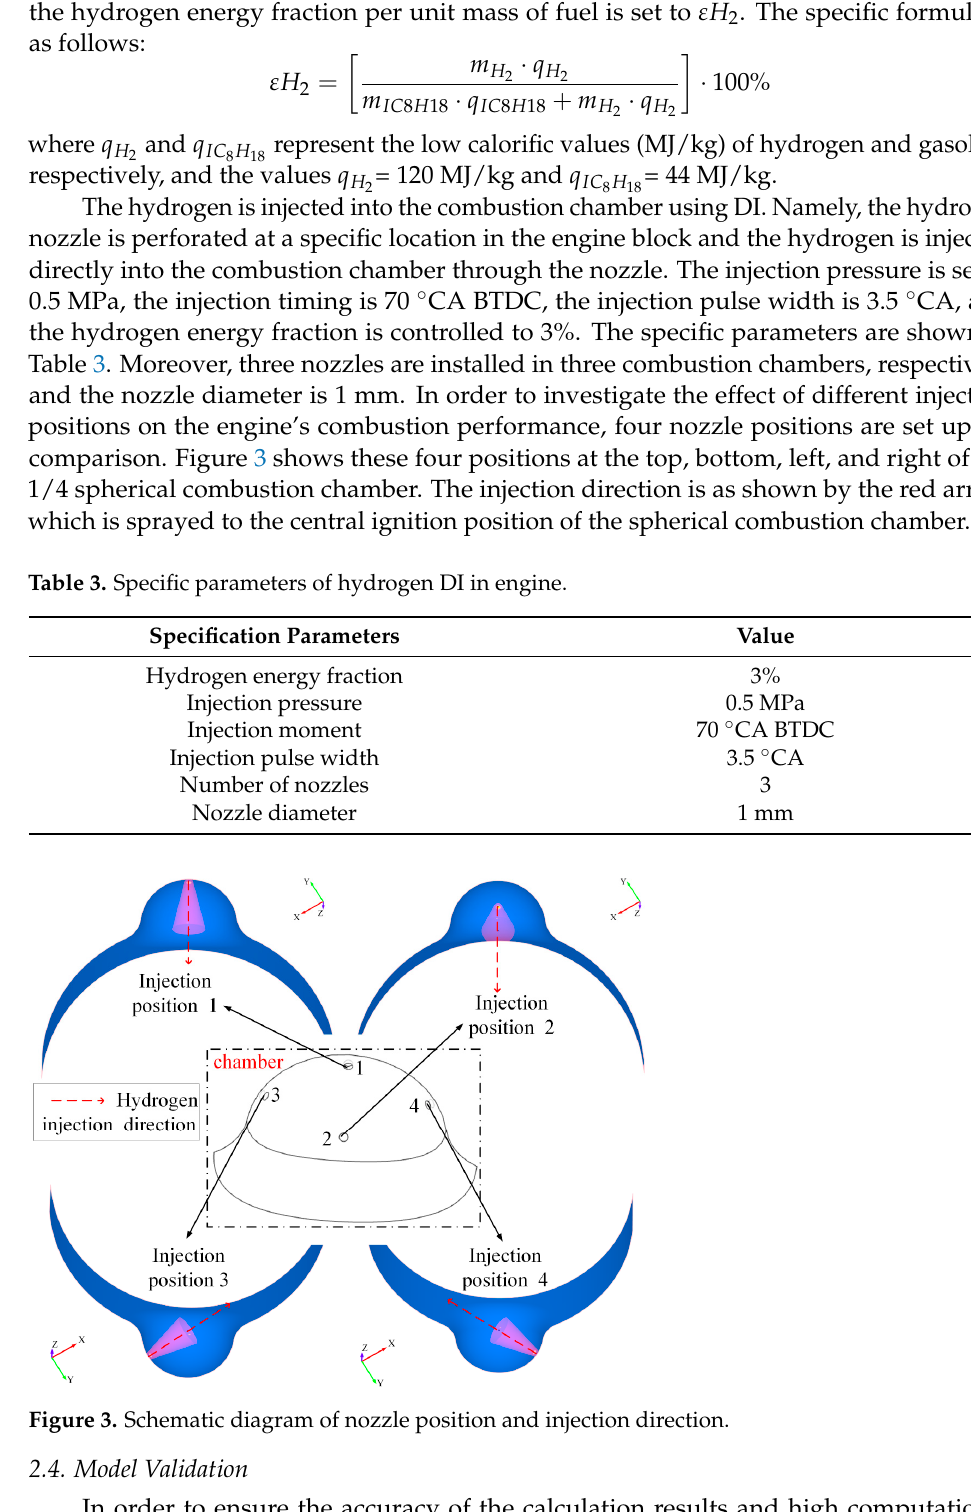
Figure 4. In-cylinder mean pressure under different grid sizes. In order to verify the accuracy of the CFD model, the calculations were set up at two operating conditions of 10,000 RPM and 9000 RPM, respectively. At 10,000 RPM, only the three strokes of intake, compression, and exhaust are calculated. At 9000 RPM, the gaso- line combustion is entirely calculated, which is the full load. This paper is based on the experiments carried out by the Liquid Piston company [12,13]. The initial conditions of the experiments are consistent with the simulation boundary conditions, as shown in Ta- ble 2. The experiments were carried out in the dynamometer test facility, and the engine was controlled by a National Instrument system. In addition, the dynamic pressure sig- nals were measured by the Kistler 6052C piezoelectric sensor (Winterthur, Switzerland). The fuel was commercial ethanol-free gasoline. 280